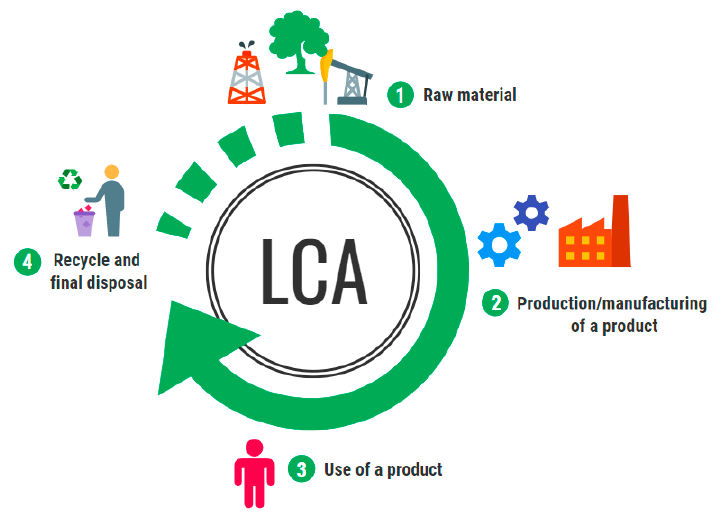
Figure 4. Life-cycle stages of a product.